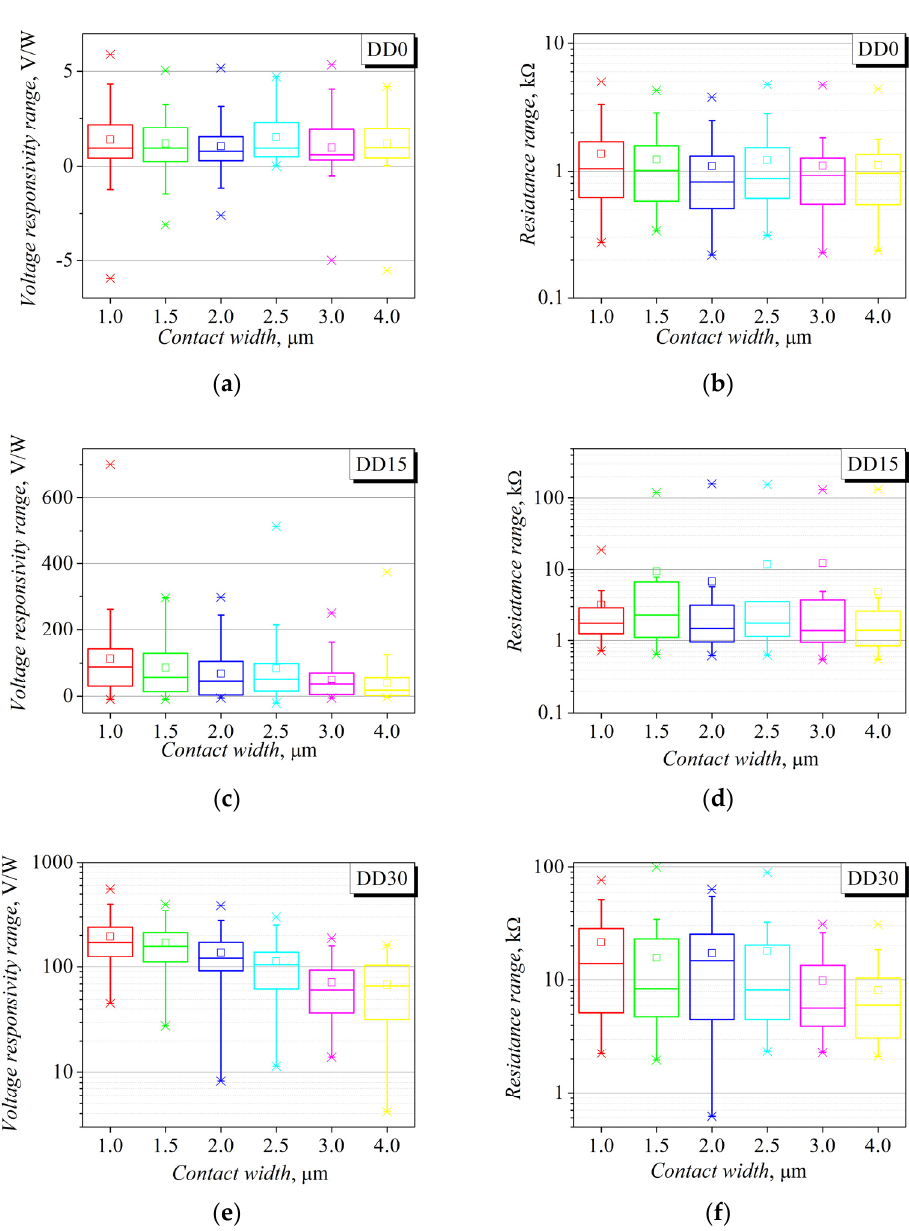
Figure A1. Box-charts of the voltage responsivity ( a , c , e ) and electrical resistance ( b , d , f ) of the planar microwave diodes DD0 ( a , b ); DD15 ( c , d ); DD30 ( e , f )with different width of the small contact. The statistical representation was executed by testing diodes in batches each containing 480 units. The box-charts present data of the diodes on the base of GaAs (diodes DD0), on the base of Al 0.15 Ga 0.85 As (diodes DD15) and on the base of Al 0.3 Ga 0.7 As (diodes DD30) shown in Figure A1 (a, b), (c, d) and (e, f), respectively. Outputs of the fabricated planar diodes in the respective DD0, DD15 and DD30 batches are 83%; 78% and